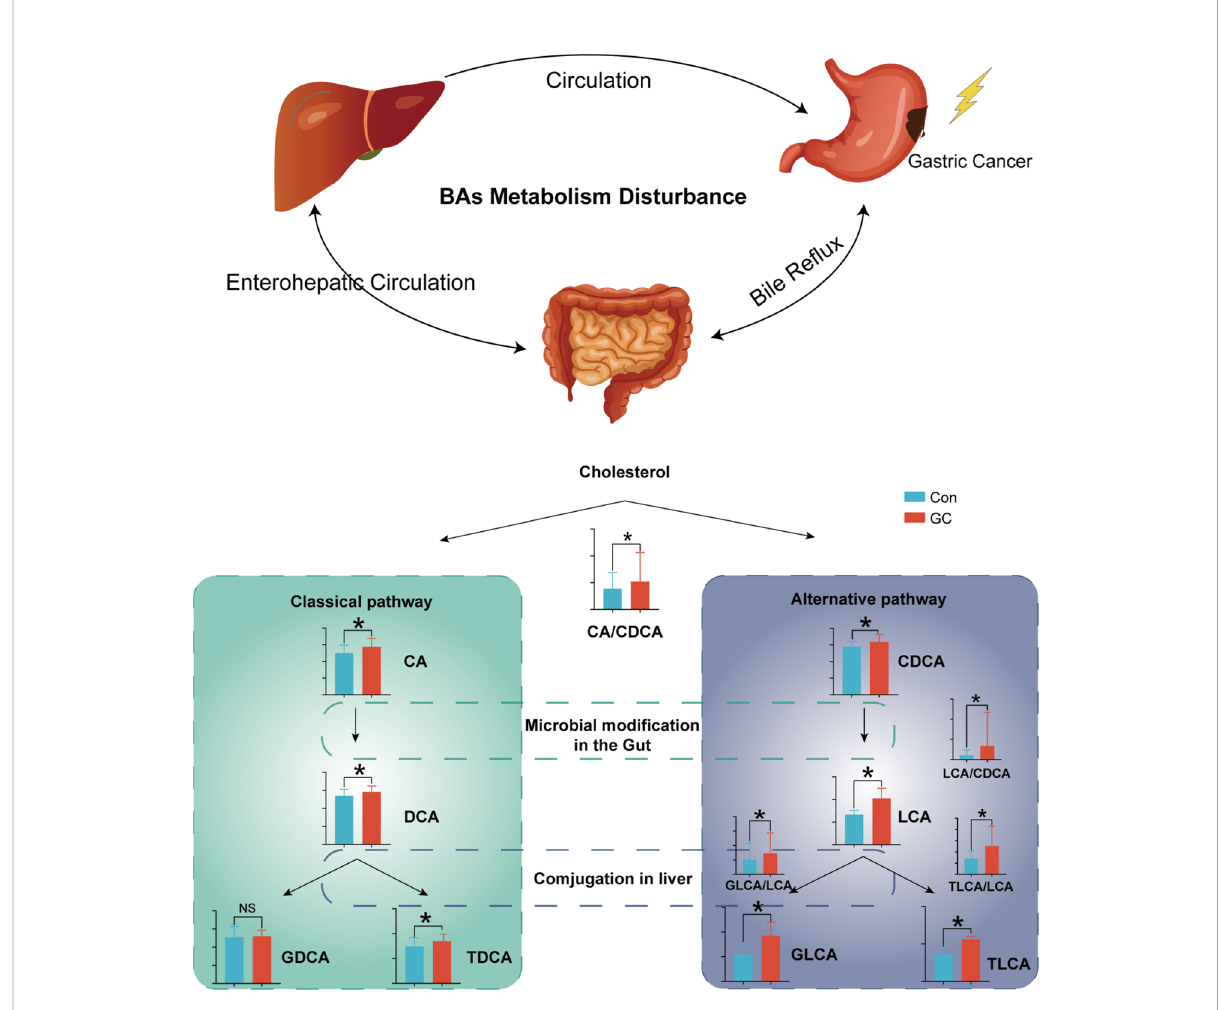
FIGURE 7 Overview of the BA metabolic dysregulation in GC. FDR-adjusted Q-value: *Q <